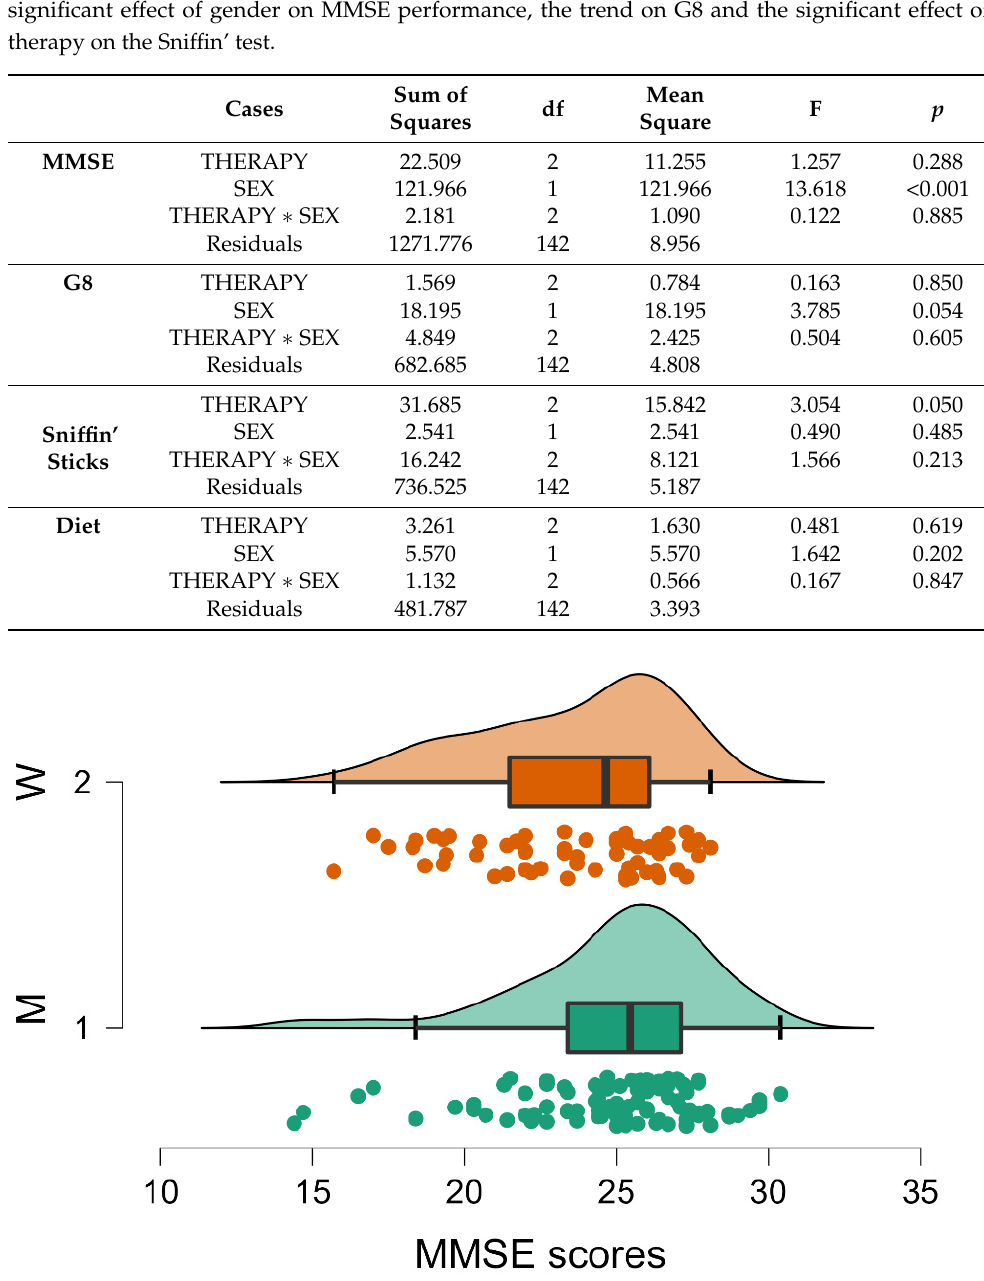
Figure 1. Raincloud plot of gender differences on MMSE showing significantly lower scores ( p < 0.001) for women (W, Group 2) compared to men (M, Group 1). Median, interquartile range and maximum and minimum scores are represented by the thick vertical line, the box and the right and left whiskers, respectively. Curves and individual dots represent the data distribution.